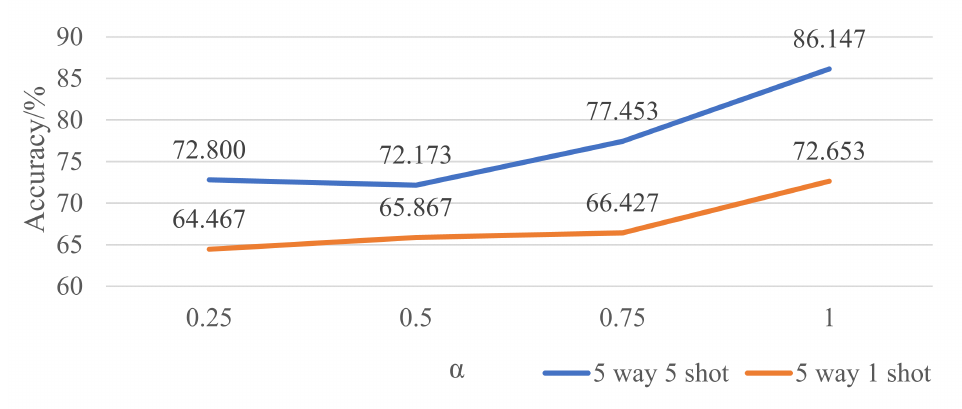
Figure 10. Experiments on extra loss from clustering of the whole set against α in both five-way one-shot and five-way five-shot